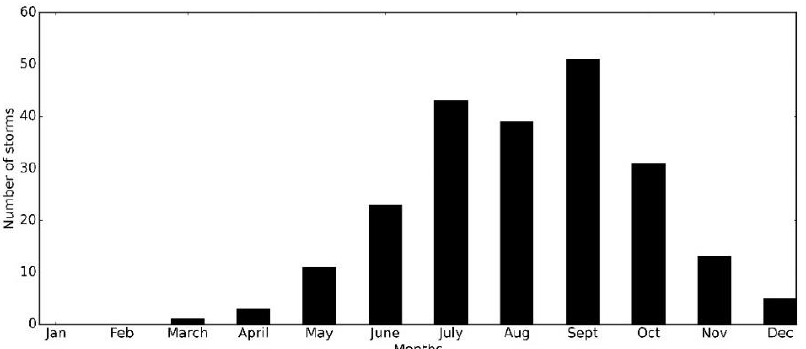
Figure 22. Monthly distribution of tropical storm tracks affecting the Xisha Islands in the South China Sea from 1988 to 2019.